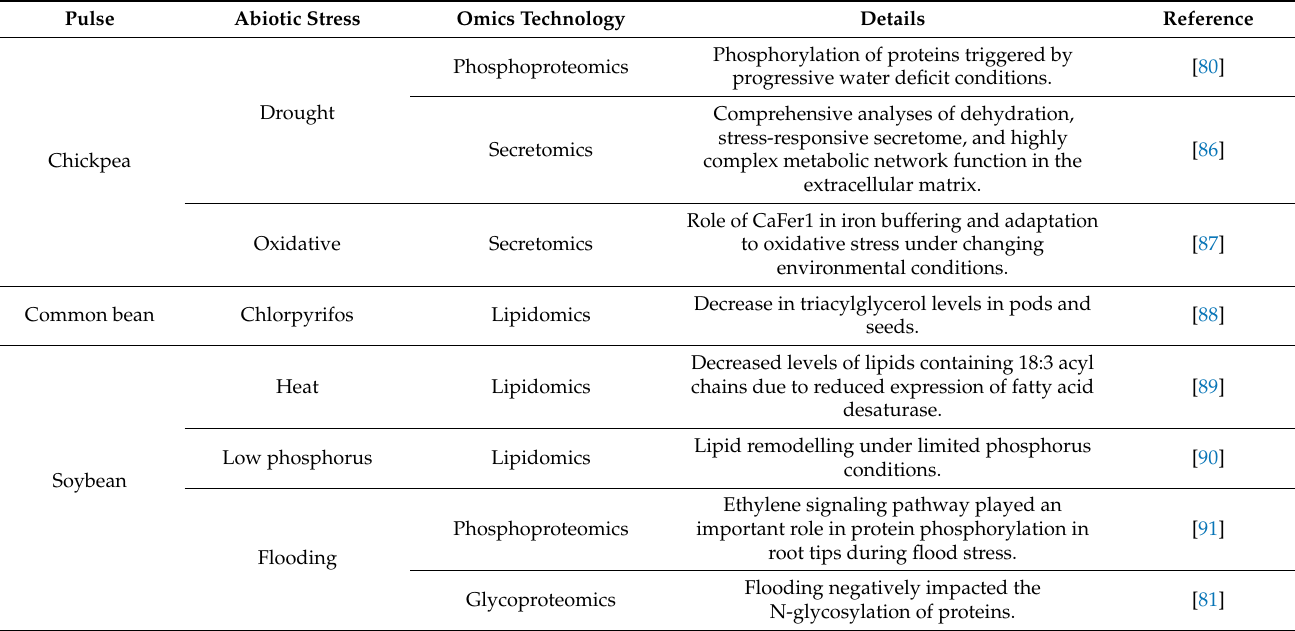
Table 2. New omics technologies for pulse